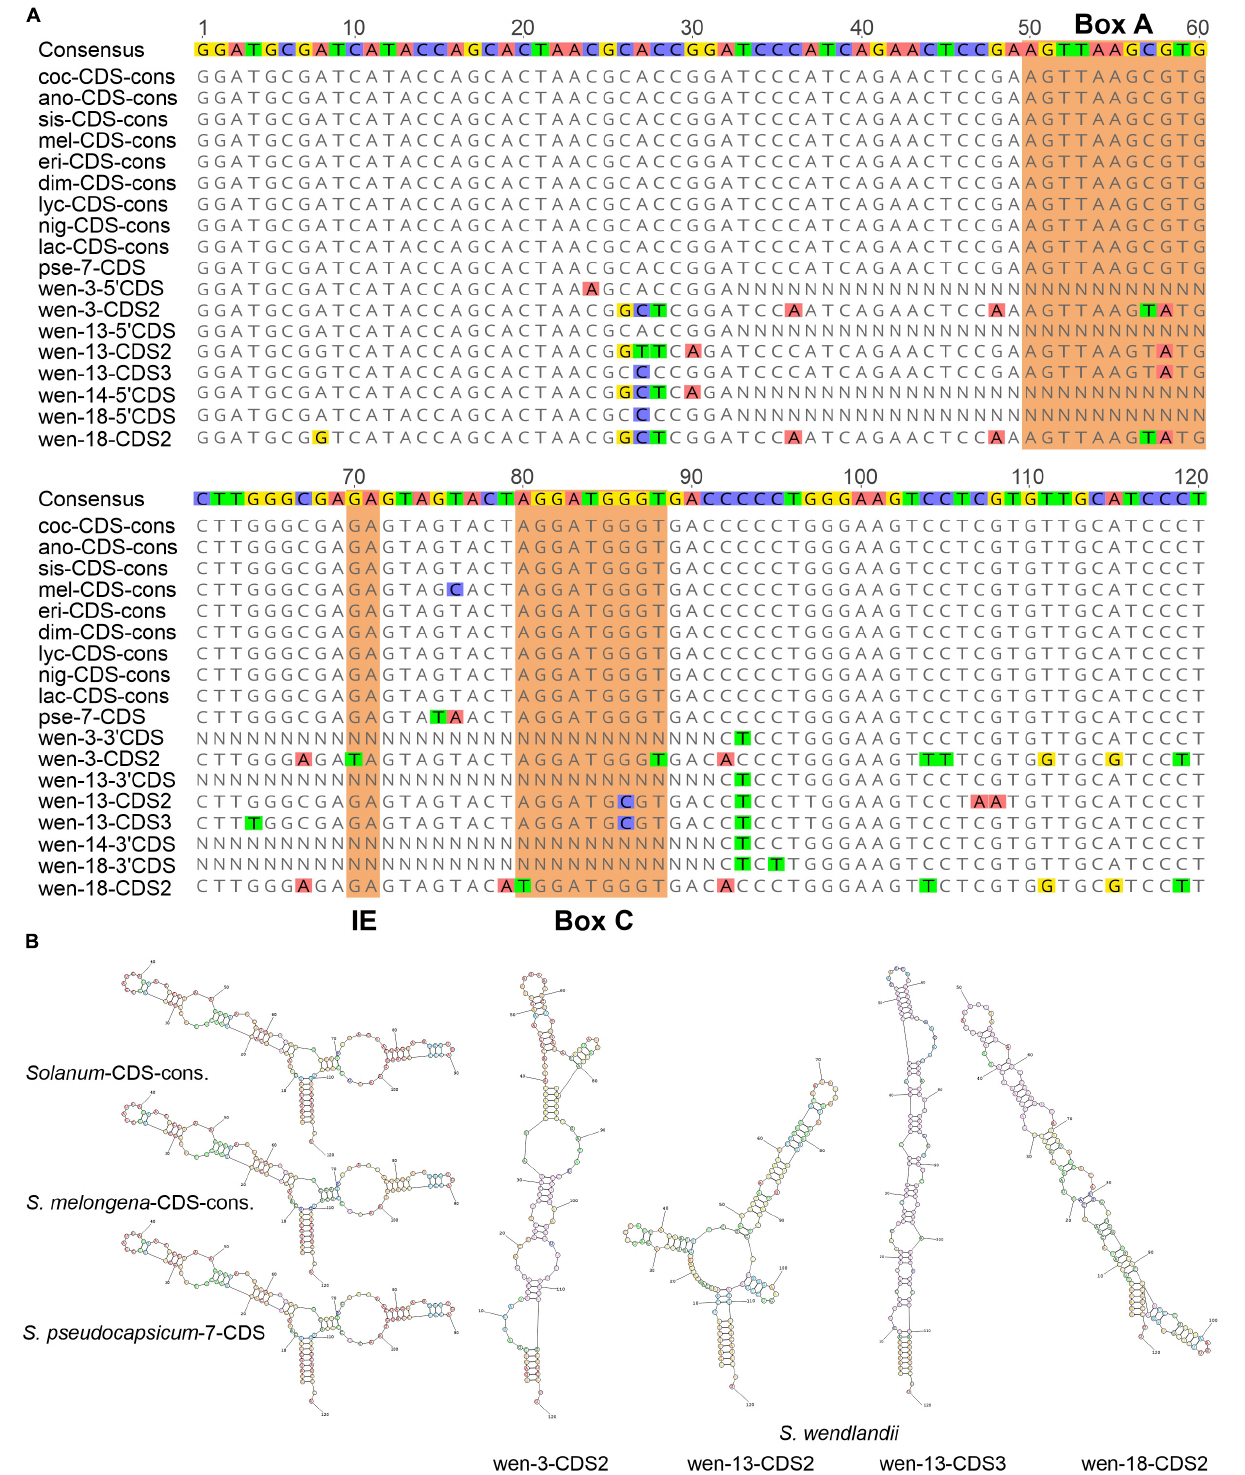
Frontiers in Plant Science |